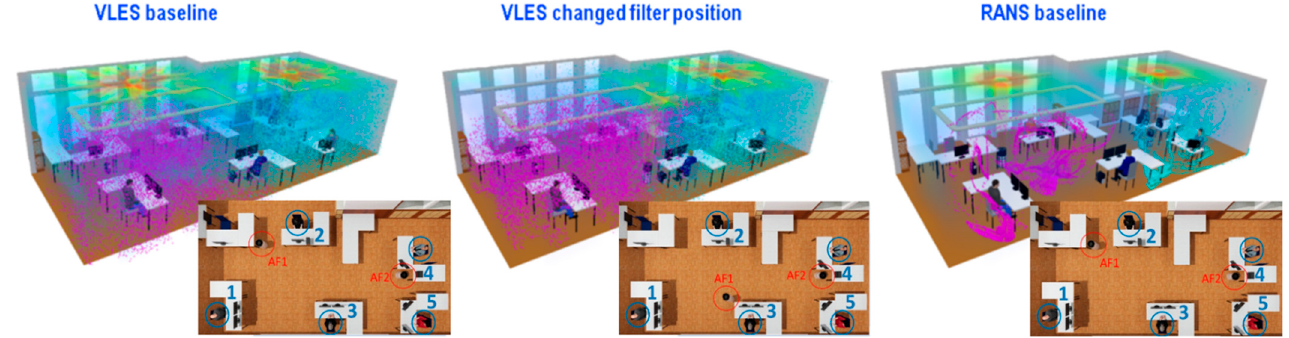
Figure 18. Distribution of the particle concentration for a coughing scenario simulated after 120 s.